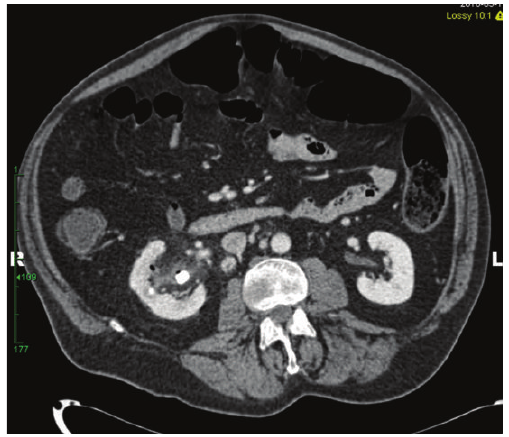
Figure 1: CT abdomen with contrast demonstrates right nephrolithiasis, stranding of the renal pelvis, and gas within the right collecting system.